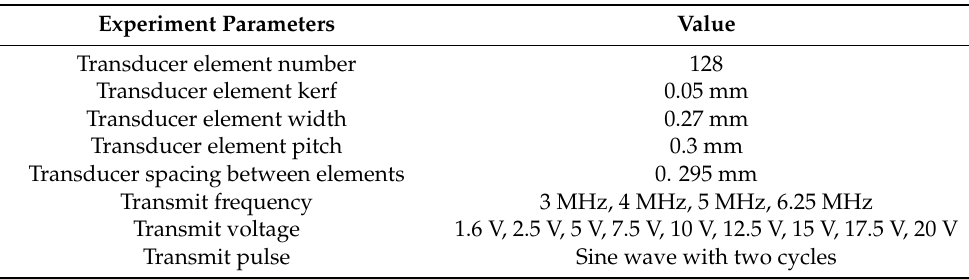
Table 2. Parameters for the experiment.